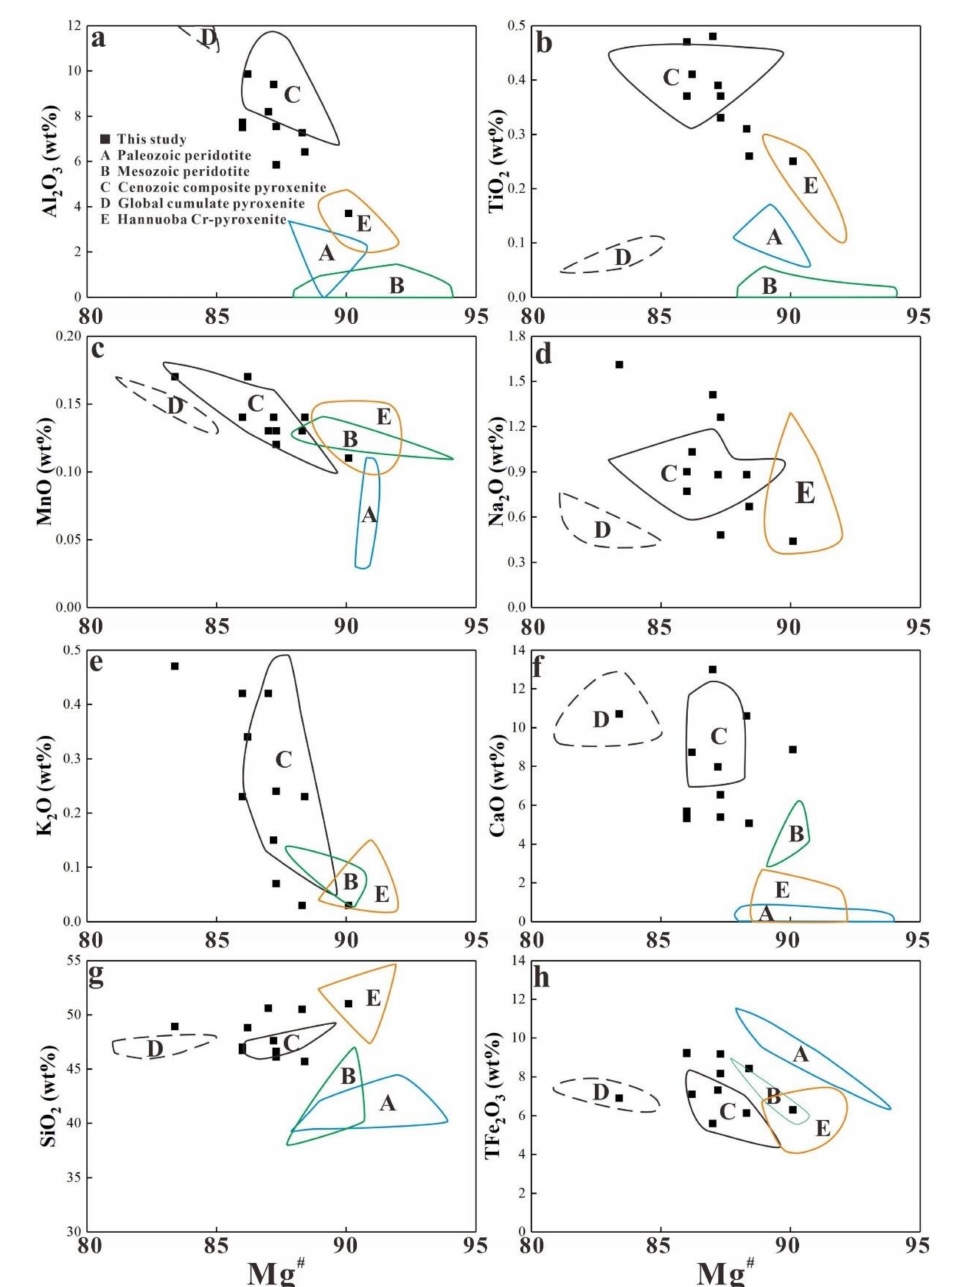
Figure 4. Harker diagrams for major element compositions of the websterite xenoliths from Hann- uoba. ( a ): Plots of Mg # vs. Al 2 O 3 ; ( b ): Plots of Mg # vs. TiO 2 ; ( c ): Plots of Mg # vs. MnO; ( d ): Plots of Mg # vs. Na 2 O; ( e ): Plots of Mg # vs. K 2 O; ( f ): Plots of Mg # vs. CaO; ( g ): Plots of Mg # vs. SiO 2 ; ( h ): Plots of Mg # vs. TFe 2 O 3 . Note: the Paleozoic peridotite represents the remnant of Archean lithospheric mantle after partial melting [37]; the Mesozoic peridotite represents the residual Archean lithospheric mantle, which was later transformed by the mantle metasomatism involving the conti- nental crust materials [37]; Cenozoic composite pyroxenites represents the product of peridotite-melt interaction [38]; the global cumulate pyroxenite represents pyroxenite with the cumulate origin [39]; Cr-pyroxenite of Hannuoba represents the residual residual-genetic pyroxenite through different degrees of melting of the primitive mantle